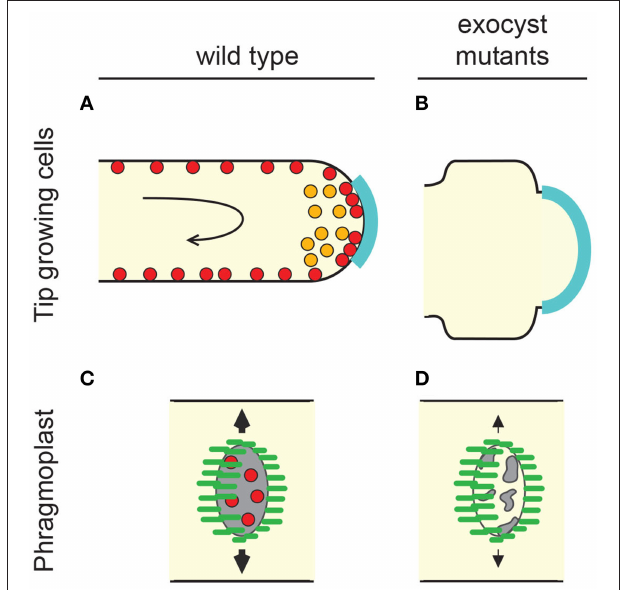
FIGURE 2 | The plant exocyst supports tip-growth and cell division. (A) Tip-growing cells in plants (pollen tubes and root hairs) incorporate membrane and other cargoes delivered via vesicles to the apical growth zone of the PM (cyan). Rapid, rotational streaming of cytoplasm (black arrow) occurs behind the apex and is driven by myosin and actin cables. In pollen tubes SEC6, SEC8, and Exo70 label endomembrane compartments within the apex (orange). In both pollen tubes and root hairs exocyst components decorate the PM in a punctate pattern (red). (B) Loss of exocyst causes shortening and broadening of tip-growing cells. This is potentially consistent with a hypothetical widening of the growth zone (cyan) but could also be caused by alterations in cell wall properties that could result in turgor-driven expansion. (C) Plant cells produce new cell plates (gray) through the action of a cytoskeletal array known as the phragmoplast (microtubule organization within the phragmoplast is depicted in green). The phragmoplast expands from the former site of the spindle and advances toward the outer cell walls where the cell plate will eventually fuse. Exocyst components are enriched at the developing plate during two distinct plate growth phases (red) (Fendrych et al., 2010; Zhang et al., 2013; Rybak et al., 2014 ). (D) Exocyst mutants show a variety of cell plate phenotypes including reduction in the rate of cell plate expansion, increase in the probability of cell plate collapse, and alteration of the content of developing cell walls. See text for details and other